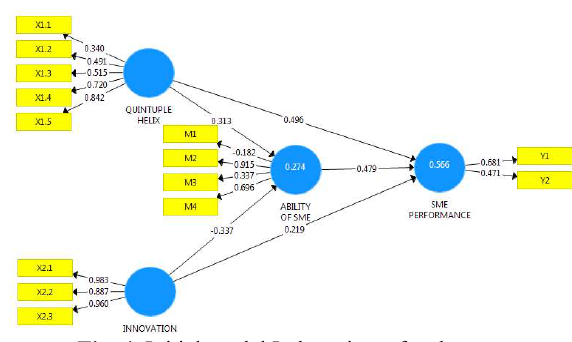
Fig. 4. Initial model Indonesia craft